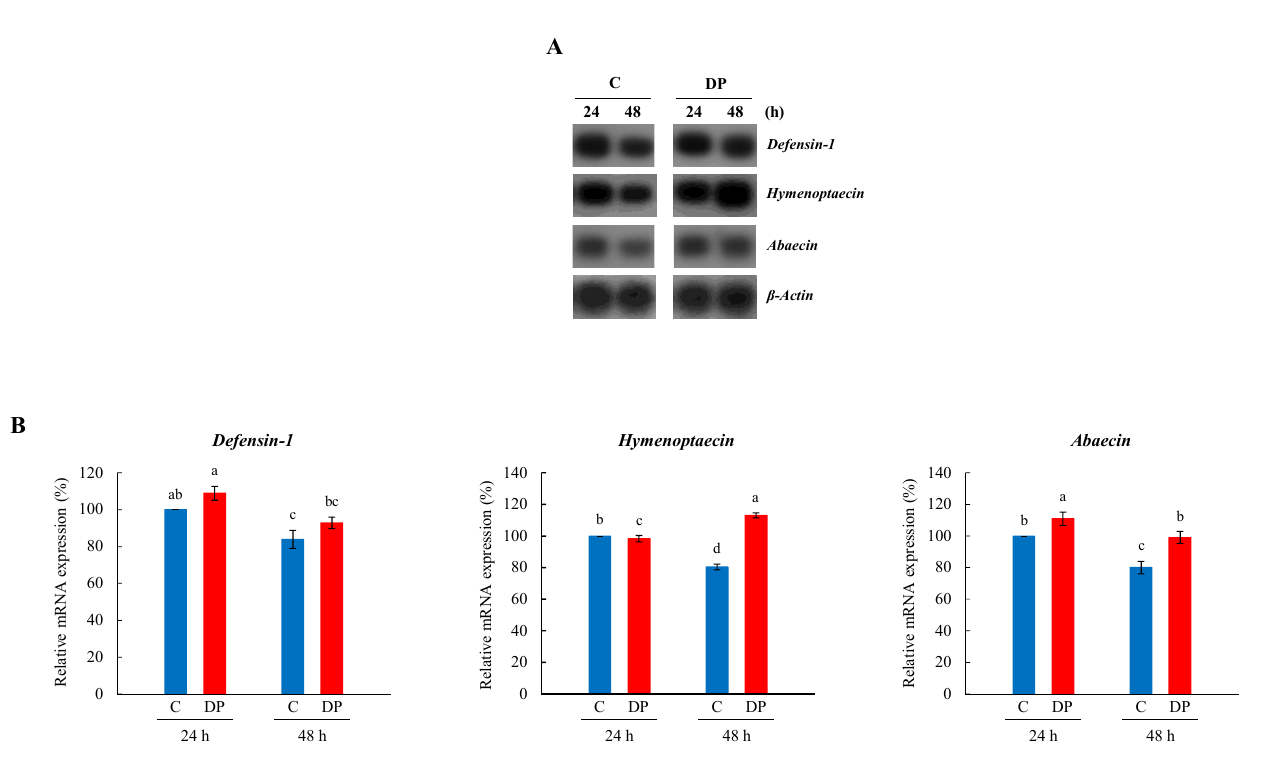
Figure 3. Expression profile of defensin-1 , hymenoptaecin , and abaecin in the whole body of A. mellifera young larvae fed with heat-killed P. larvae . ( A ) The expression of defensin-1 , hymenoptaecin , and abaecin , as ascertained by northern blot analysis ( n = 9). β -Actin was used as an internal control to depict the total RNA loading amount. C, untreated controls; DP, feeding with heat-killed P. larvae . 24 h and 48 h represent feeding time. ( B ) The relative levels of defensin-1 , hymenoptaecin , and abaecin mRNAs represent the average band densities of the target genes normalized to the expression levels of the control (24 h). The bars represent the mean ± SD from three measurements. A one-way ANOVA test was used to determine the significant difference ( p < 0.05) with different lowercase letters (a–d).